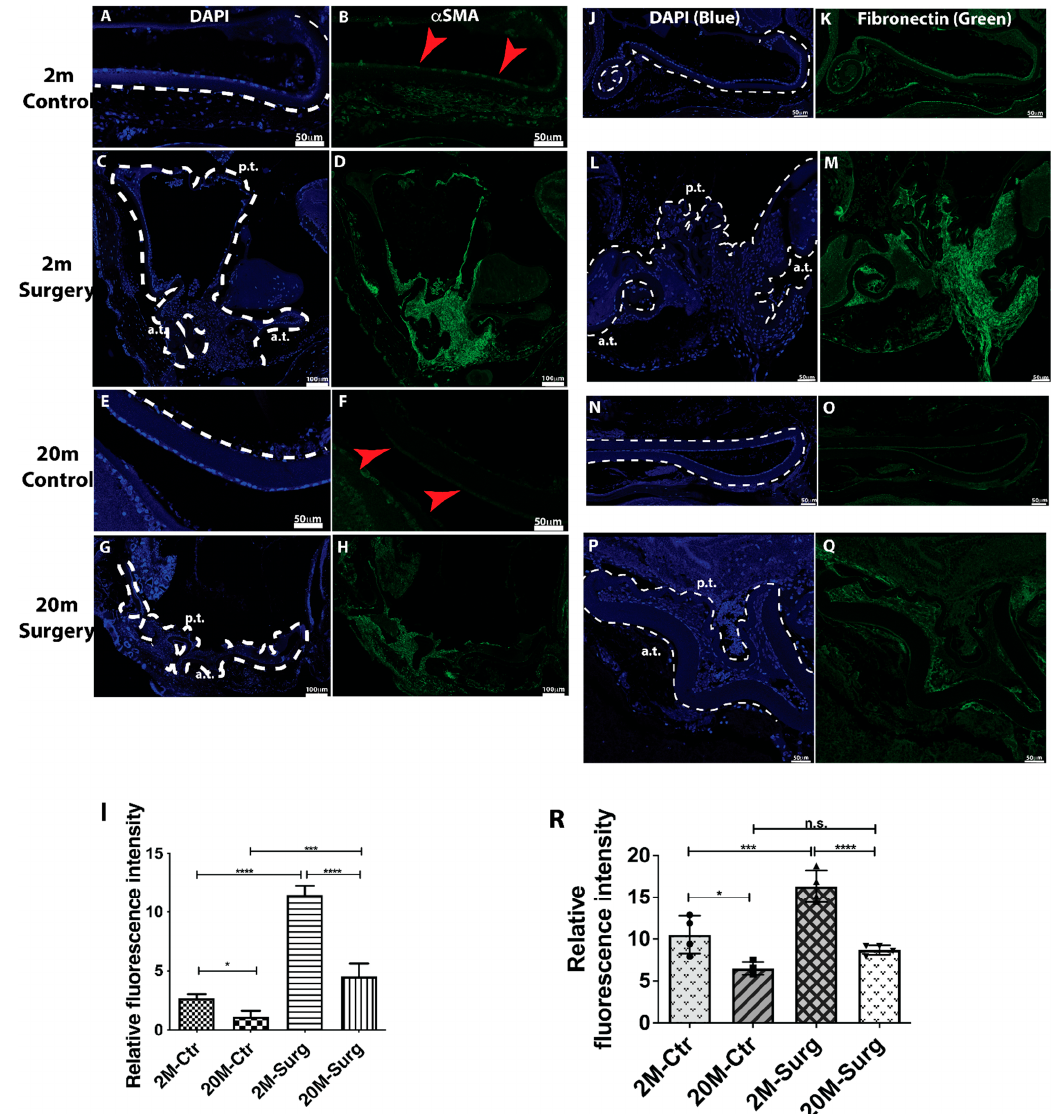
Figure 6. α SMA and fibronectin protein expression in 2- and 20-month-old mouse lens capsules after cataract surgery. ( A , C , E , G ) Cell nucleus staining by DAPI is shown in blue. ( B , D , F , H ) α SMA antibody staining is shown in green. ( A ) Two-month control, DAPI. ( B ) Two-month control, α SMA. ( C ) Two-month surgery, DAPI. ( D ) Two-month surgery, α SMA. ( E ) Twenty-month control, DAPI. ( F ) Twenty-month control, α SMA. ( G ) Twenty-month surgery, DAPI. ( H ) Twenty-month surgery, α SMA. ( I ) Quantitative results of α SMA protein expression based on fluorescence intensity (n = 4). ( J , L , N , P ) Cell nucleus stain by DAPI is shown in blue. ( K , M , O , Q ) Fibronectin antibody stain is shown in green. ( J ) Two-month control, DAPI. ( K ) Two-month control, fibronectin. ( L ) Two-month surgery, DAPI. ( M ) Two-month surgery, fibronectin. (N) Twenty-month control, DAPI. ( O ) Twenty- month control, fibronectin. ( P ) Twenty-month surgery, DAPI. ( Q ) Twenty-month surgery, fibronectin. ( R ) Quantitative results of fibronectin protein expression based on fluorescence intensity (n = 4). Re- sults are expressed as mean ± SD and were analyzed using one-way ANOVA with Tukey’s multiple comparisons test. Only p < 0.05 is considered significant. * < 0.05, ** < 0.01, *** < 0.001, **** < 0.0001; n.s., not